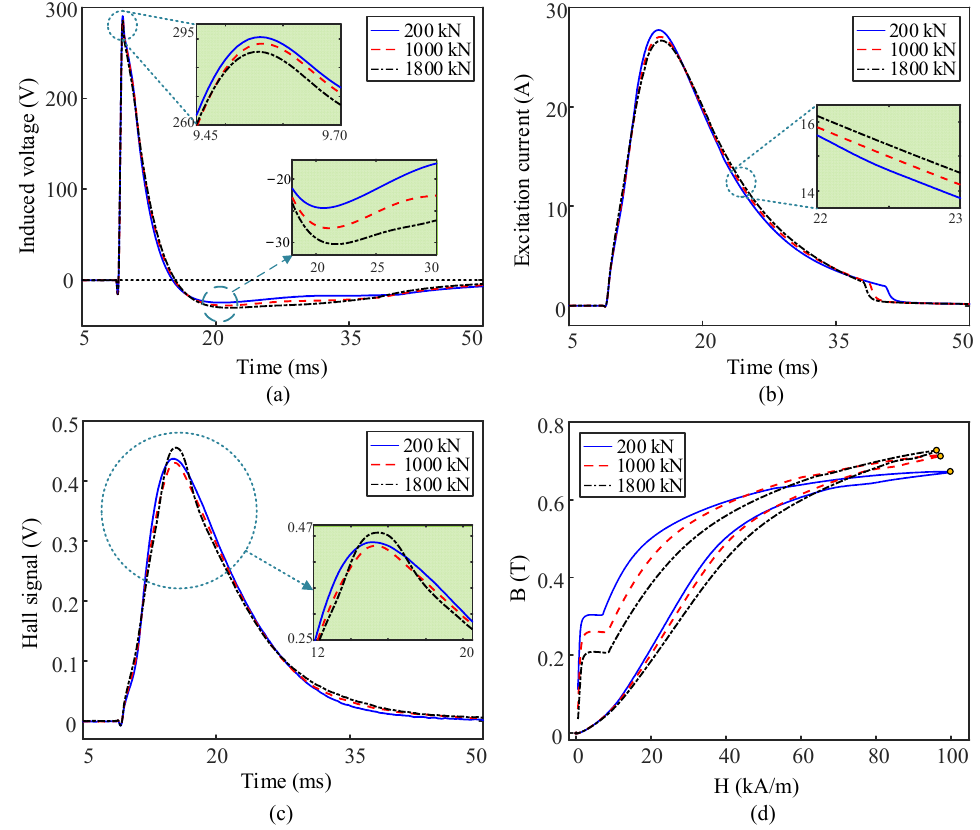
Figure 4. ( a – d ) Typical waveforms of the induced voltage, excitation current, output signal of Hall sensor, and B-H curve obtained under different cable forces, respectively.